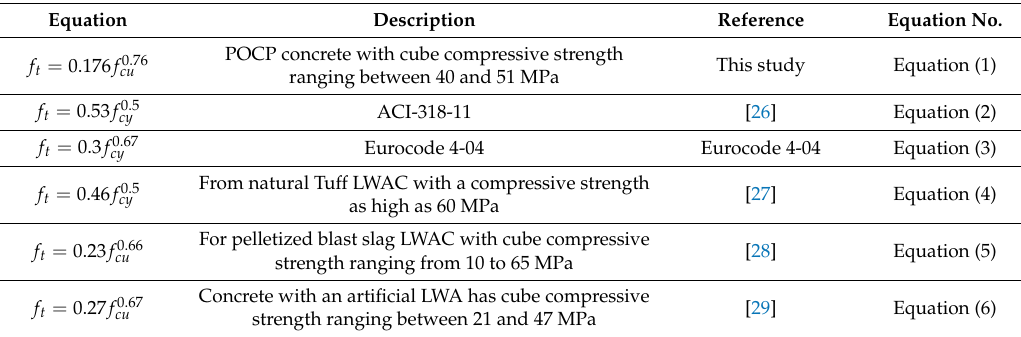
Table 6. Practical equations for splitting tensile strength of concrete.